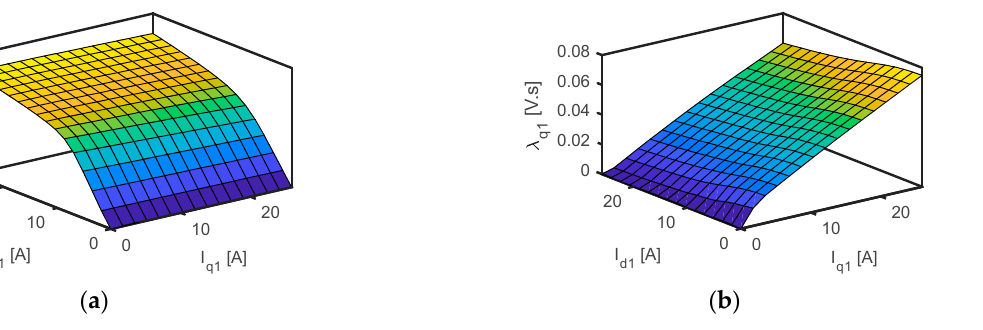
Figure 2. Average value of ( a ) fundamental d-axis flux-linkage and ( b ) fundamental q-axis flux- linkage at different i d1 and i q1 .